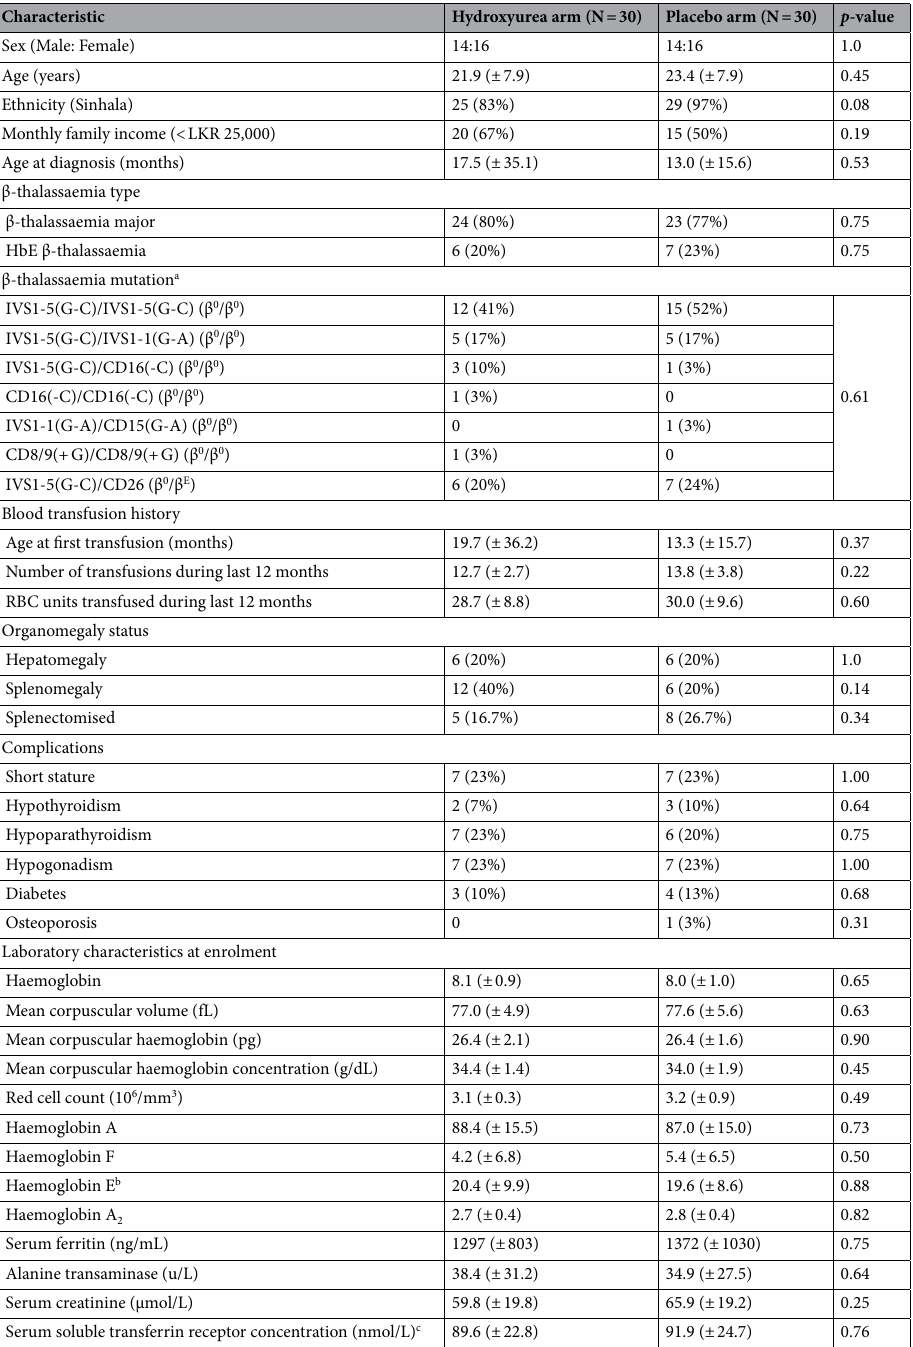
Table 1. Baseline socio-demographic, clinical, laboratory and genotype characteristics of the intention to treat population. Data are n (%) or mean (± SD). P -values are from χ 2 or independent sample t-test. a Data from